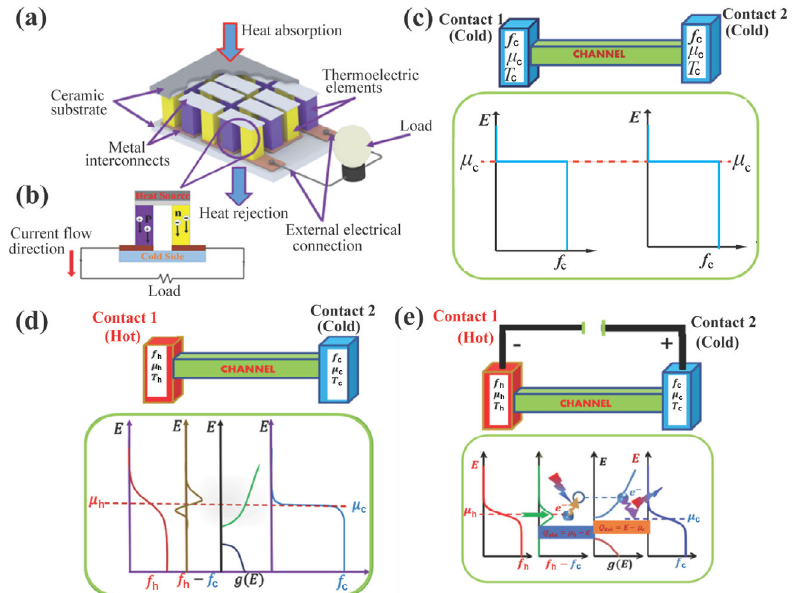
Figure 1 (a) A typical thermoelectric device. (b) A TE n-type and p-type legs in the device design. Adapted with permission from Ref. [19], © WILEY-VCH Verlag GmbH & Co. KGaA, Weinheim 2017. (c) Initial stage of a thermoelectric device with no applied potential and temperature. (d) A TE device with temperature gradient leading to current flow due to difference in electrochemical potential (